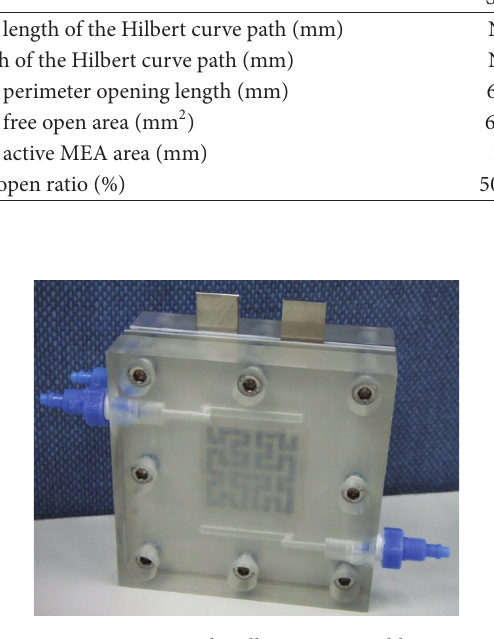
Figure 2: Single cell DMFC